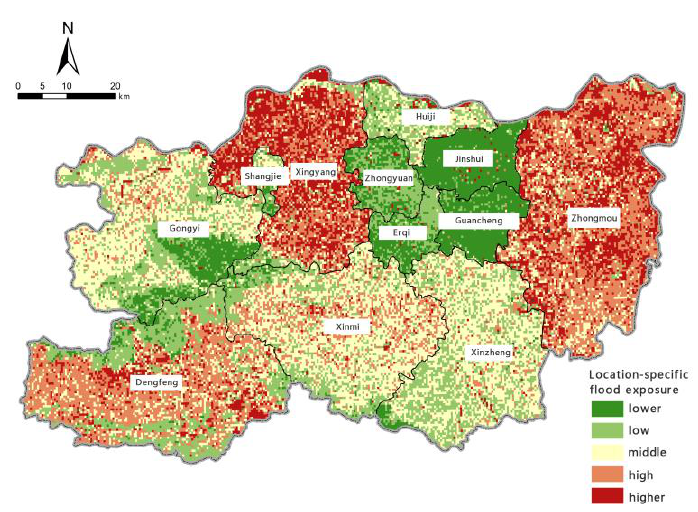
Figure 8. Zoning map of location-specific flood exposure.